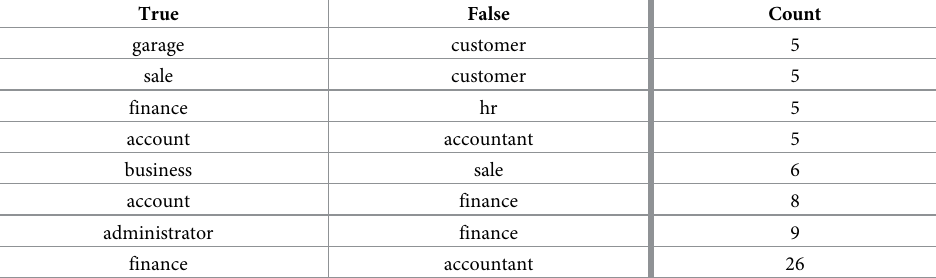
Table 2. Out of 8844 examples in the test set 196 are misclassified. The most common confusion made by the deci- sion tree seems to be between office finance roles e.g. ‘finance’ includes jobs like ‘finance assistant’ and ‘purchase ledger clerk’ which have similar requirements to ‘accountant’ jobs. Many of these jobs are classified similarly by Reed them- selves, so the small number of classification errors are made on ambiguous ads, showing the strength of the